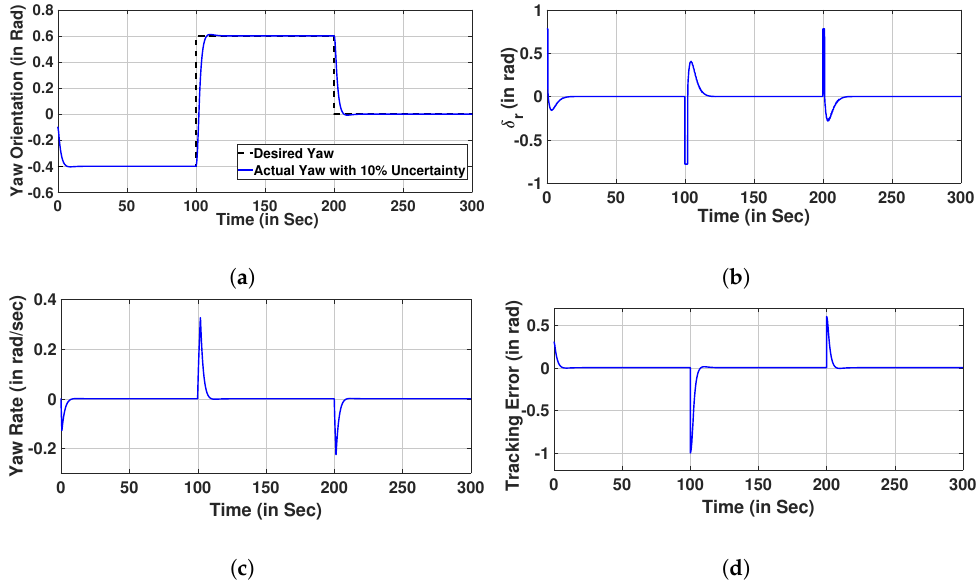
Figure 7. Control of yaw for ± 10% uncertainty. ( a ) Tracking of Desired Yaw, ( b ) Control Input, ( c ) Yaw Rate, ( d ) Error Signal.